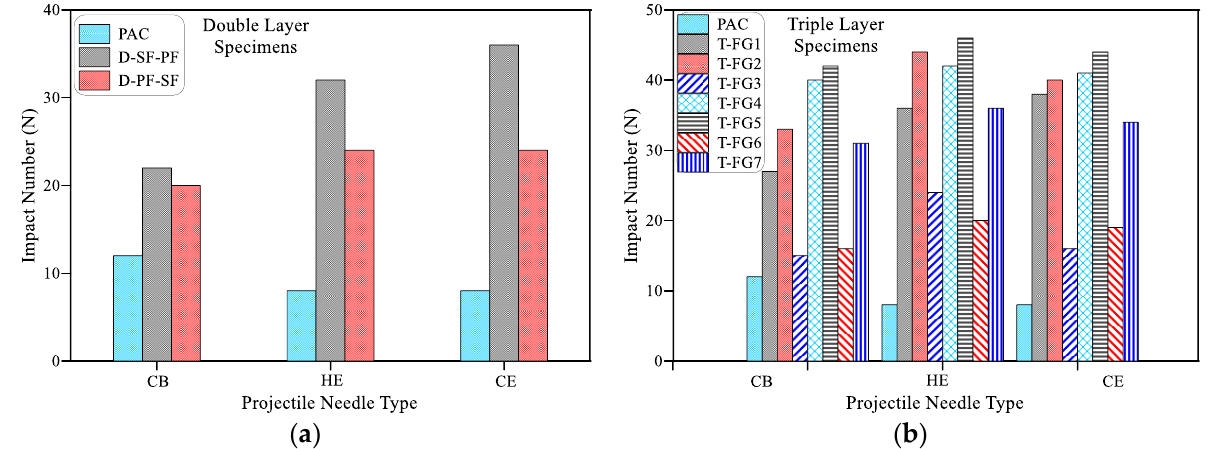
Figure 11. Effect of fibre hybridization on the failure impact number (N) of the projectile impact test. ( a ) Double layer specimens, ( b ) Triple layer specimens.